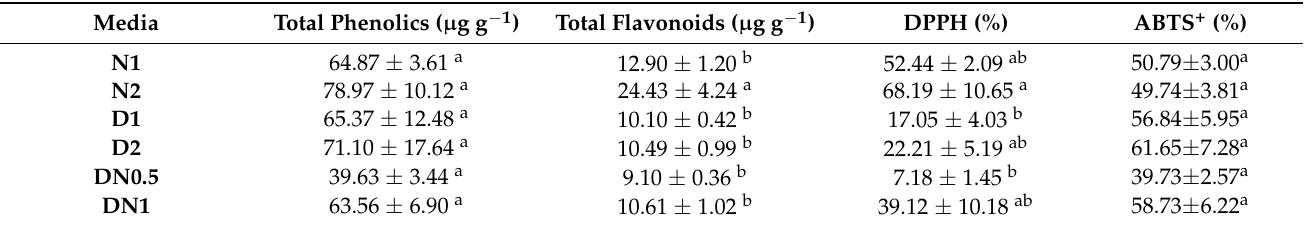
Table 4. Total phenolic, flavonoid contents, and antioxidant capacity in callus cultures of L. schweinfurthii showing the effect of different PGRs.